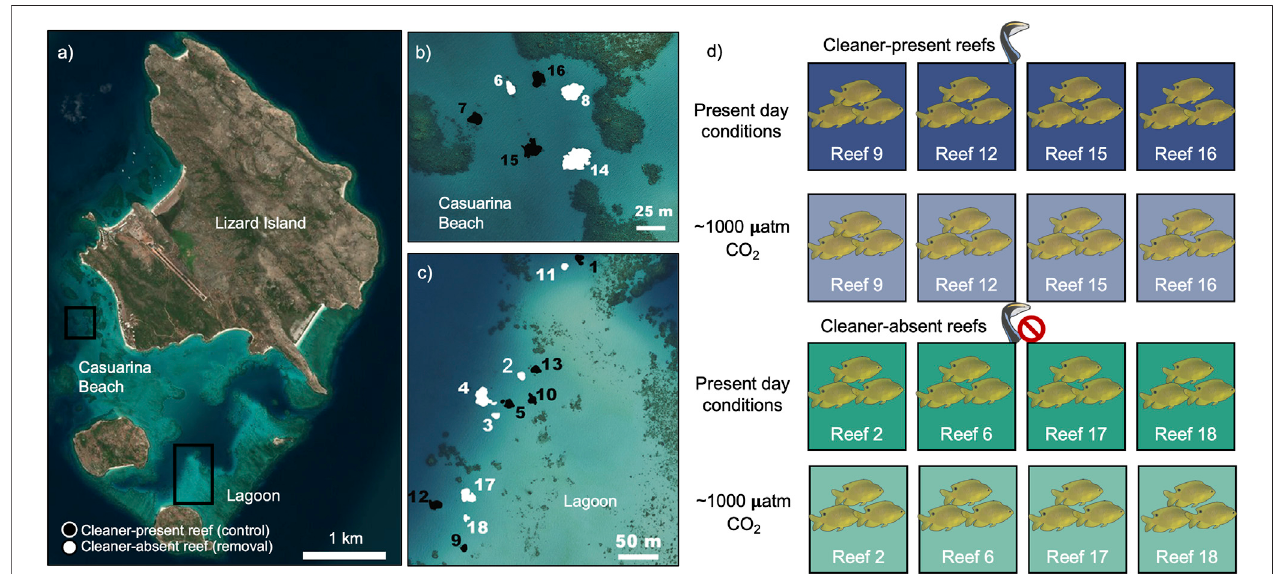
FIGURE 1 | Experimental design used in this study. On the maps (A – C) , white represent reefs where cleaner fi sh Labroides dimidiatus were removed throughout 17 years, black represent control reefs. (D) Pomacentrus amboinensis were collected from reefs 9, 12, 15, and 16 (control reefs) and reefs 2, 6, 17, and 18 (removal reefs) and acclimatedto one oftwo conditions for 20 days:Control (~350 µatm pCO 2 ) or ocean acidi fi cation (High CO 2 , ~1,000 µatm pCO 2 ).Map adapted from Grutter et al. (2019).